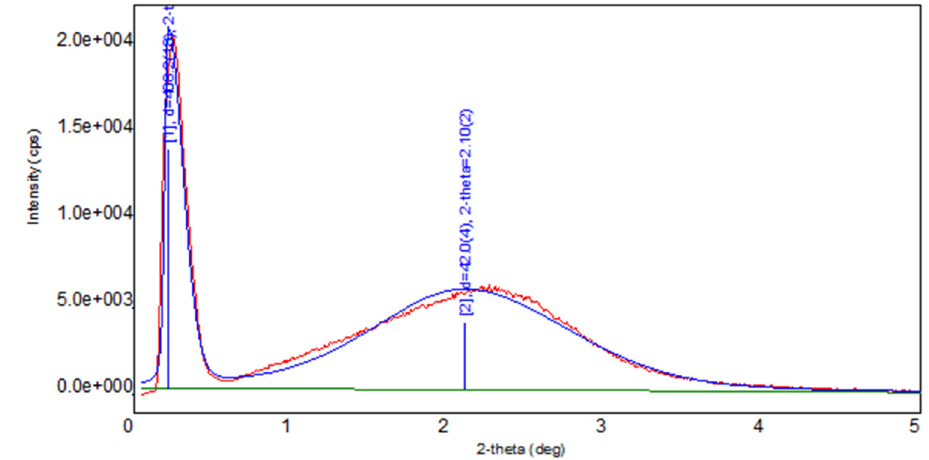
Figure 4: Small - angle X - ray scattering of